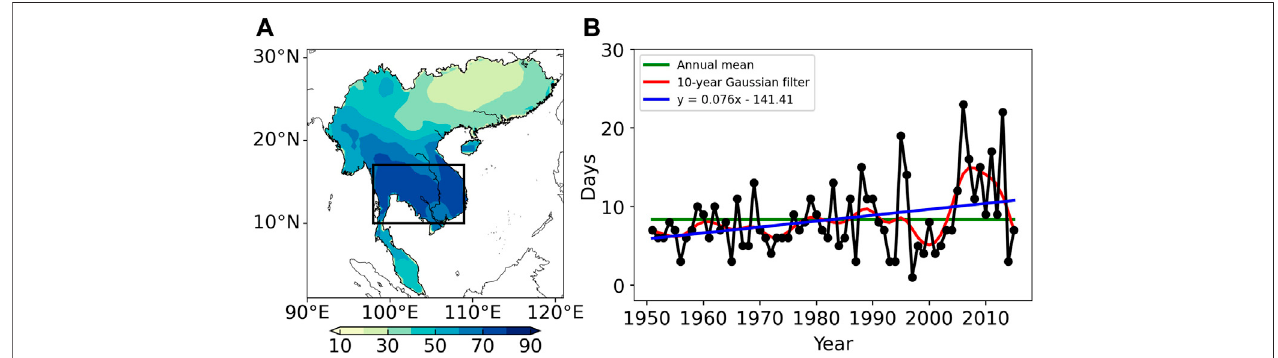
FIGURE 1 | (A) Composite precipitation percentile and (B) time series of the annual number of days of extreme precipitation (black), along with the decadal variability (red) and long-term trend (blue) for extreme precipitation of the Indochina Peninsula cluster, which are adopted from Figures 5B and 9C in Cheng et al. (2021), respectively. The box in (A) denotes the starting region of the backward